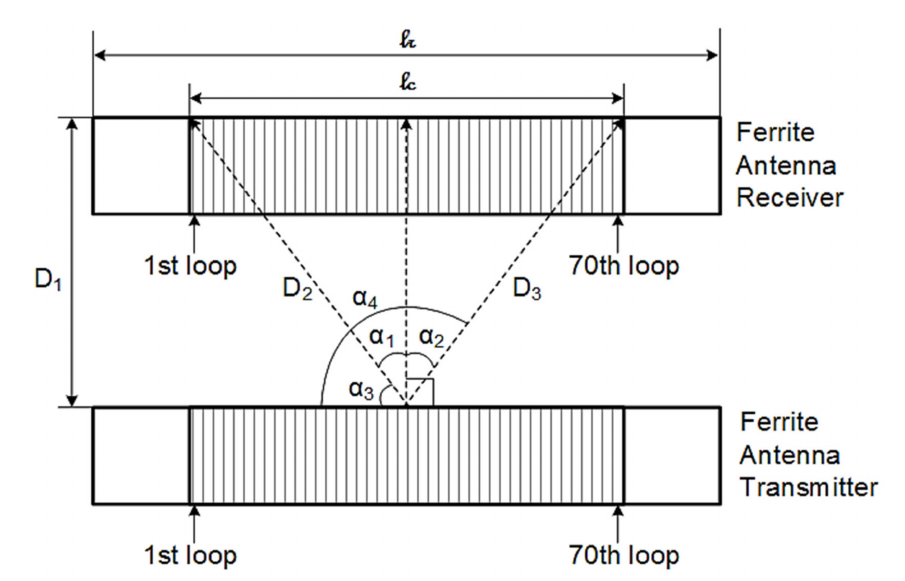
Figure 10. YZ-plane view of the transmitter and receiver of the ferrite